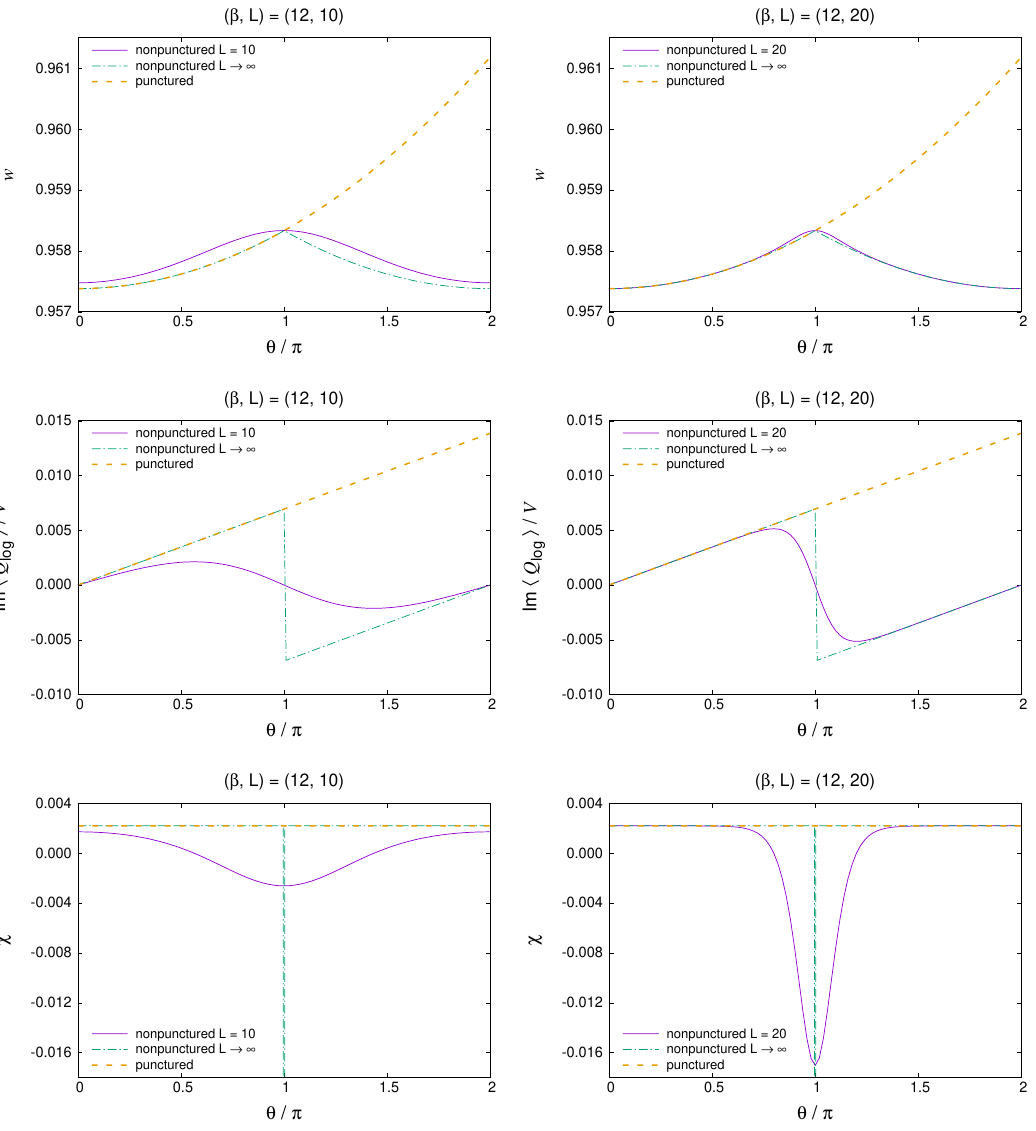
Figure 5 . The exact results for various observables obtained by using the log de(cid:12)nition Q log of the topological charge. The average plaquette (Top), the imaginary part of the topological charge density (Middle), the topological susceptibility (Bottom) obtained for the non-punctured (solid line) and punctured (dashed line) models are plotted against (cid:18) for L = 10 (Left) and L = 20 (Right) with the same (cid:12) = 12. Note that the results for the punctured model are actually independent of L . For the non-punctured model, we also plot the results in the in(cid:12)nite volume limit L (cid:12) = 12 by the dash-dotted lines for comparison.